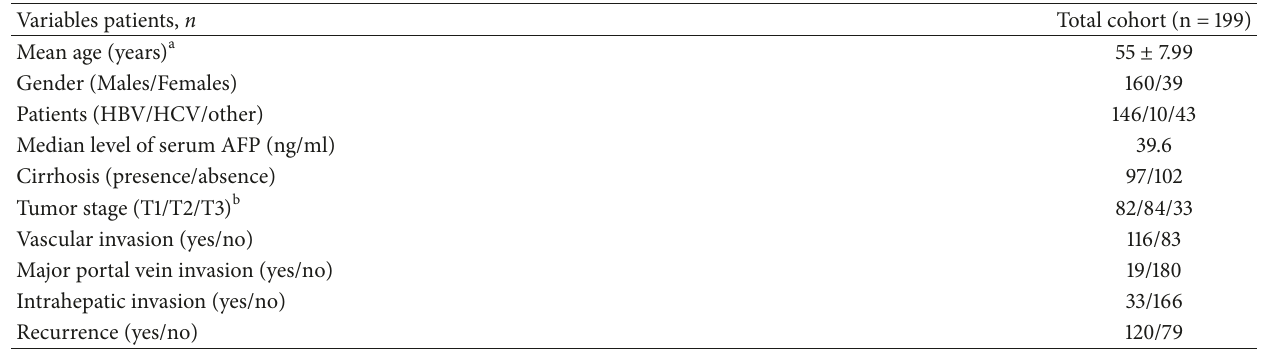
Table 1: Demographics and tumor characteristics of 199 HCC